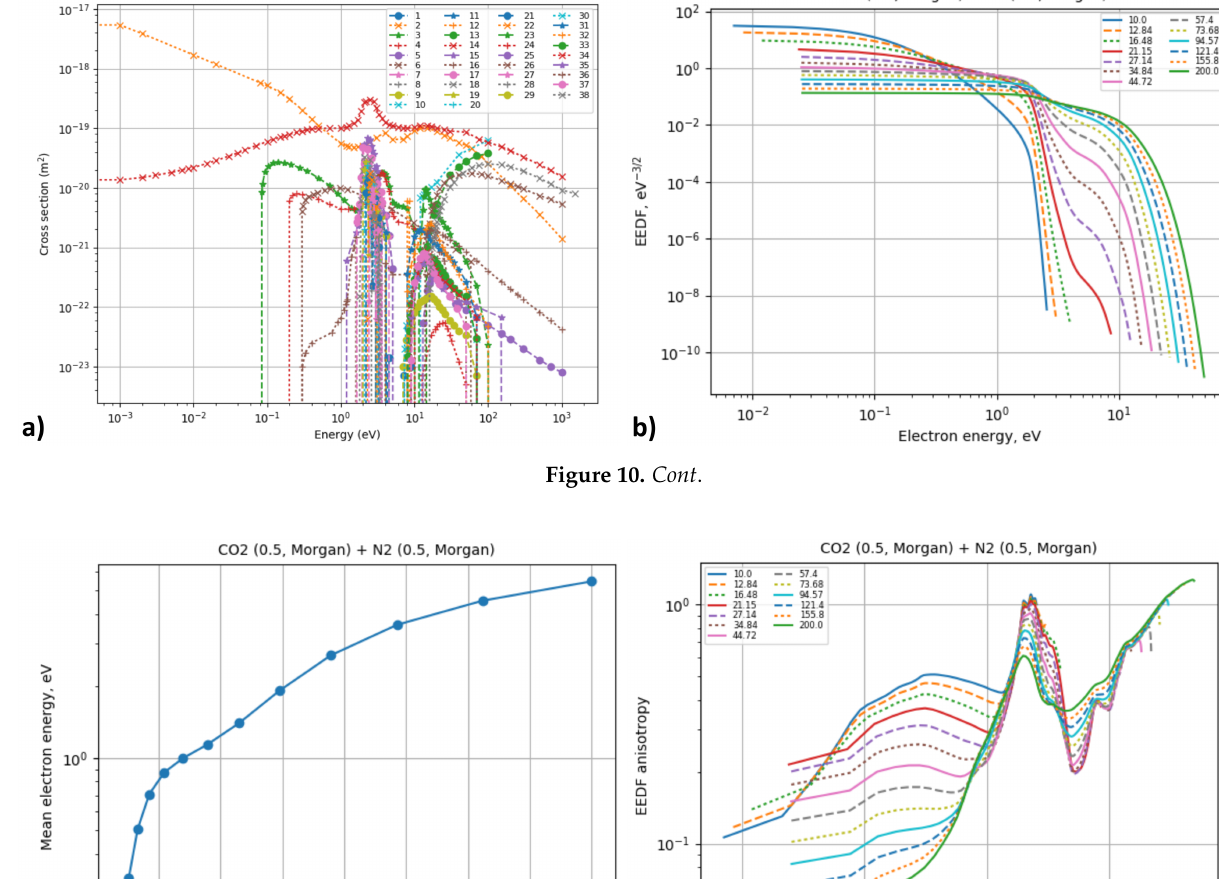
Figure 10. ( a ) Input cross-sections data from the Morgan database [110,196]: cross-sections 1–13 belong to CO N datasets) and computed quantities for a 0.5–0.5 CO 2 ( b ) electron energy distribution function (EEDFs); ( c ) mean electron energy; ( d ) EEDF